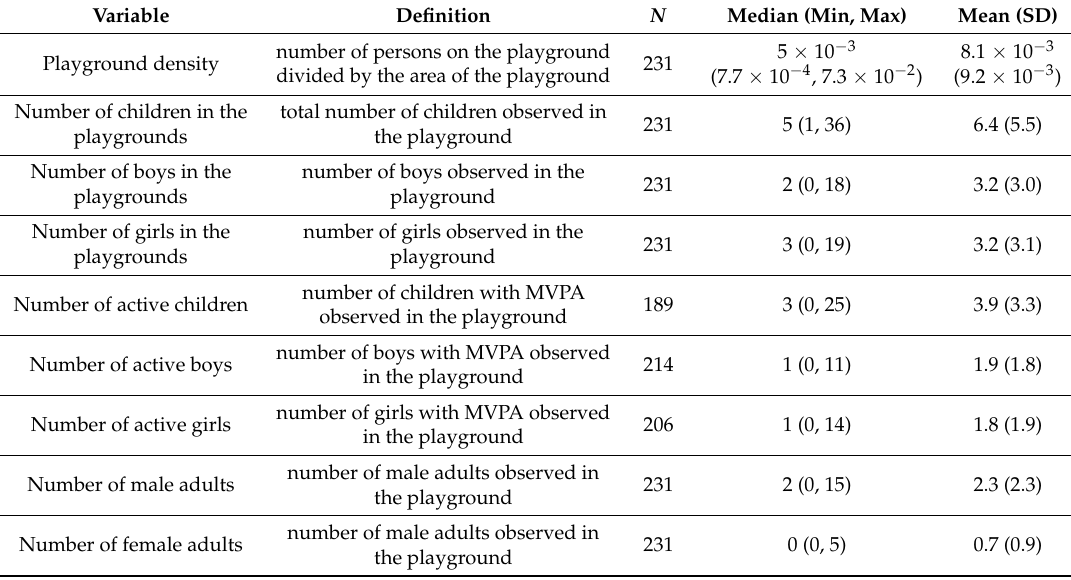
Table 1. Information on Social Environmental